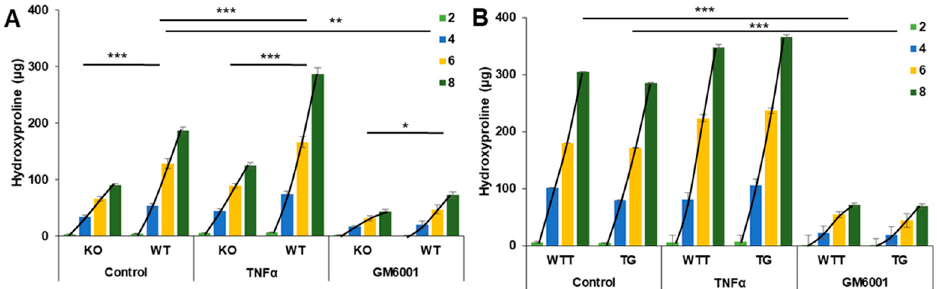
Figure 2. The effect of the MMP-3 genotype (control), TNF- α treatment and GM6001 treatment on collagen degradation in skin measured by the release of hydroxyproline-containing peptides into media from KO and WT ( A ), and WTT and TG ( B ) skin explants incubated over eight days. The timely progression of hydroxyproline release was assessed by regression analysis of the slopes. Mean ± SEM (bars). * p < 0.05, ** p < 0.01, *** p < 0.001. The number of animals ( n ) used for theses analyses is given in Table 2. TNF- α (10 ng / mL). GM6001, broad-spectrum MMP inhibitor (10 µ M). KO, MMP-3 knock-out; WT, wild-type control to KO; WTT, wild-type to transgenic mice (TG); TG, MMP-3 overexpression in skin. Light green bars, day 2; blue bars, day 4; yellow bars, day 6; dark green bars, day 8.